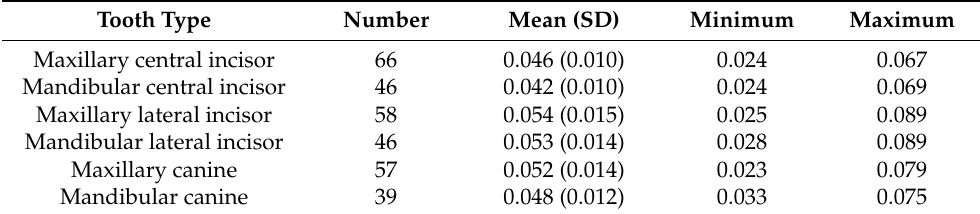
Table 2. Mean and standard deviation of pulp–tooth volume ratio in the studied teeth.